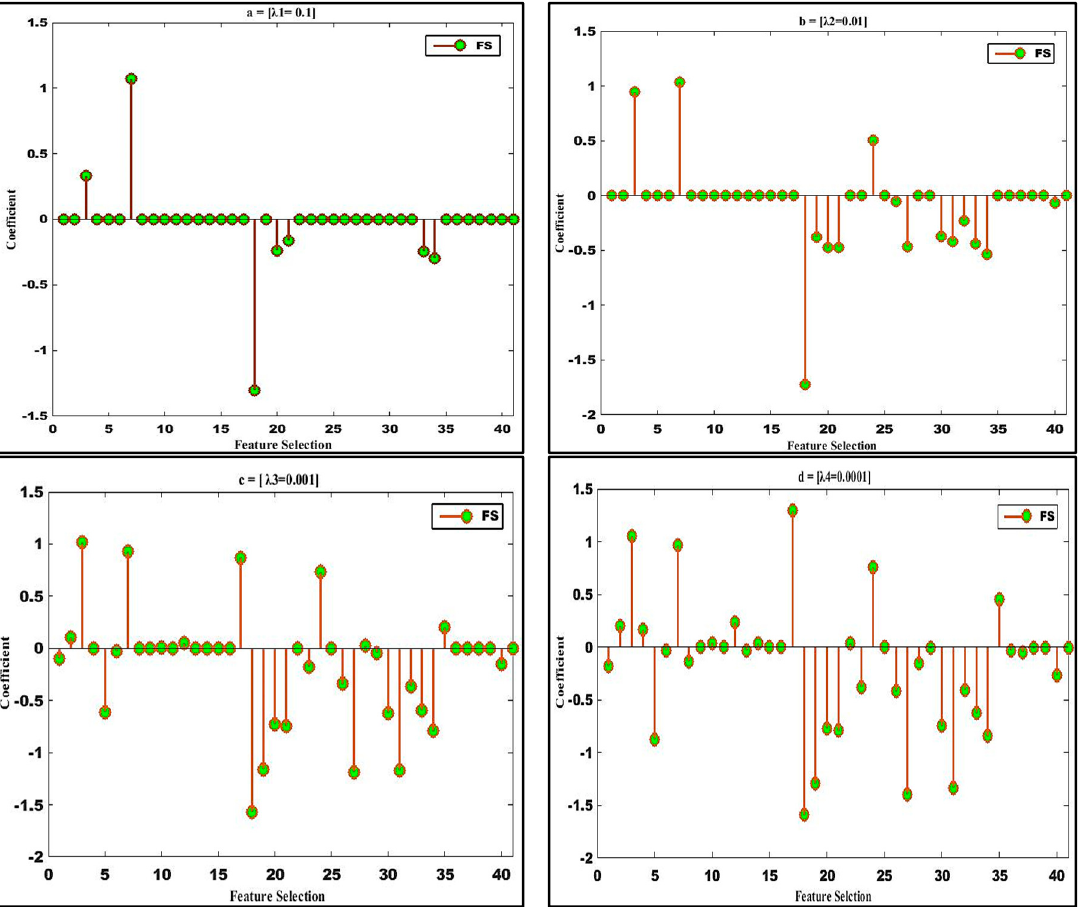
Figure 6. ( a – d ) Feature selection and degree of sparsity via SPLR on KDD ’99 dataset.